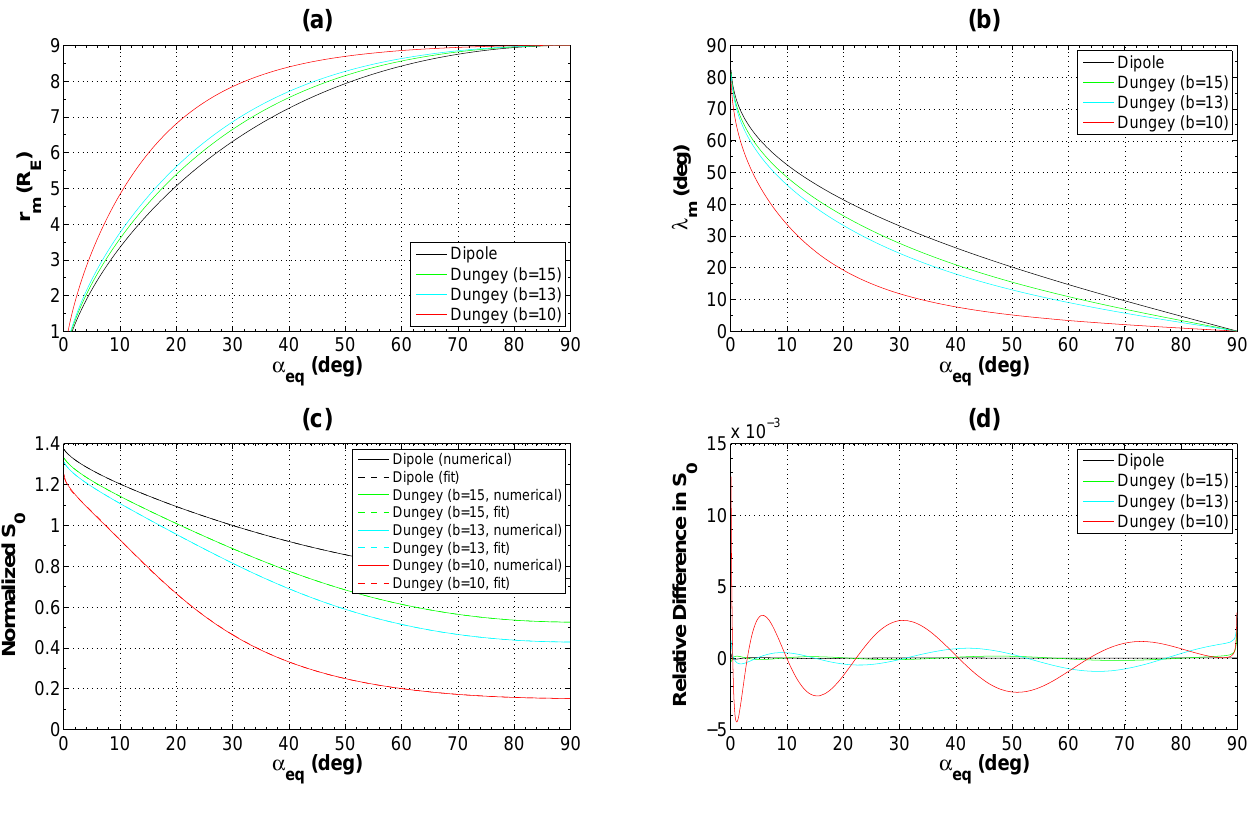
Fig. 3. Same as Fig. 2, except for r 0 = 9 R E with b / R E = ∞ (dipole), 15, 13 and 10. Table 1. Fitted values of six polynomial coefficients ( a 0 – a 5 ) for approximate representations of normalized bounce period related term S 0 as a fifth-order polynomial of p sin α eq , corresponding to the indicated multiple choices of b / R E at the equatorial crossings of r 0 = 6 R E and r 0 = 9 R E in the Dungey